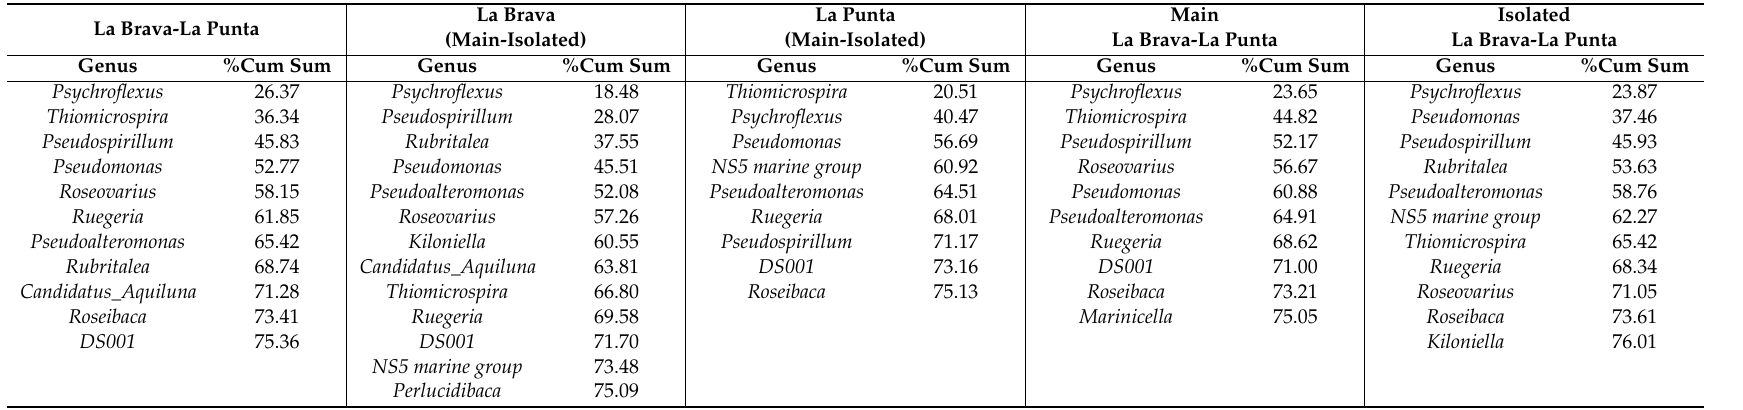
Table 4. SIMPER analysis of the main operational taxonomic units (OTUs) associated with the di ff erences between La Brava and La Punta lakes. La Brava-La